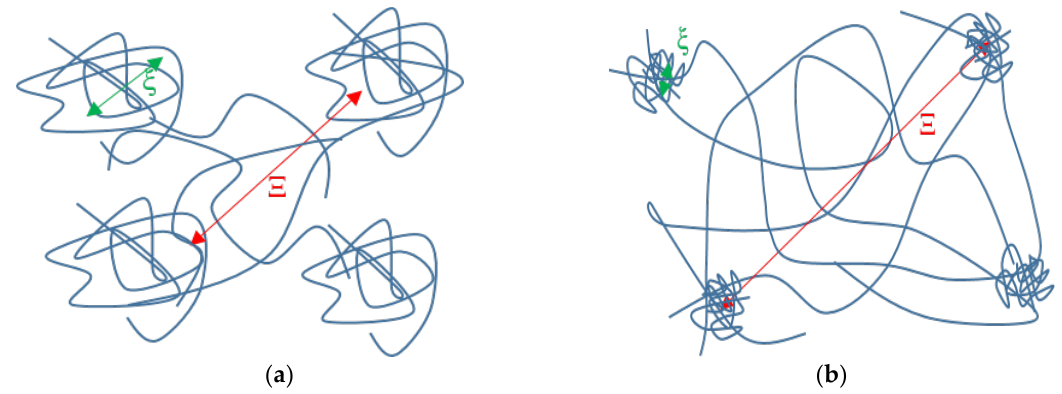
Figure 2. Depiction of plausible spatial inhomogeneities observed with ( a ) reversible deactivated radical polymerization (RDRP) polymerization and ( b ) free radical polymerization (FRP) polymerization (scheme adapted from [34] with the publisher’s permission).